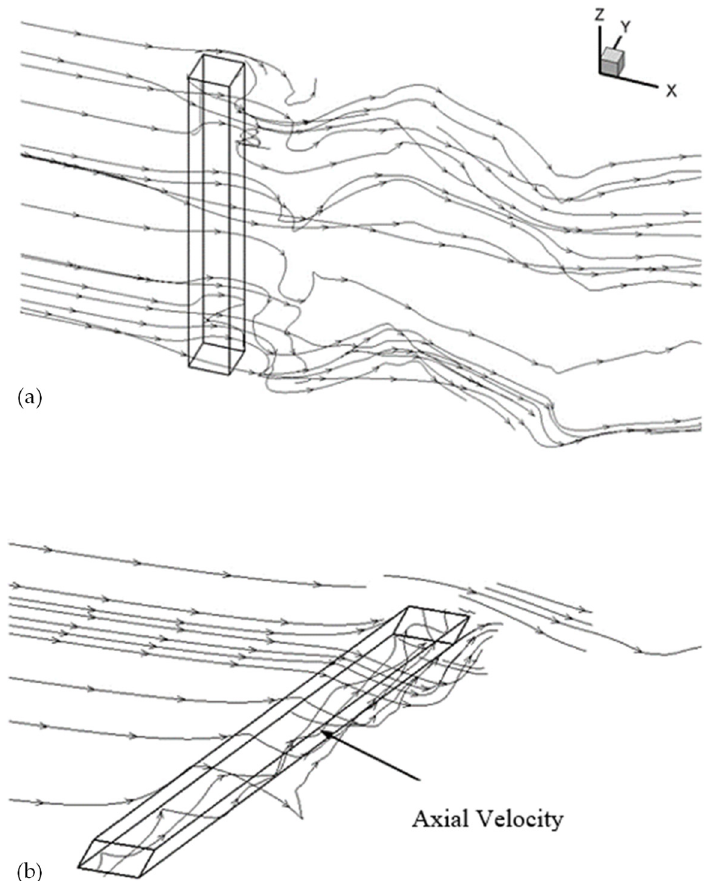
Figure 18. Streamlines around the cylinder for different yaw angles. ( a ) α = 0°; ( b ) α =